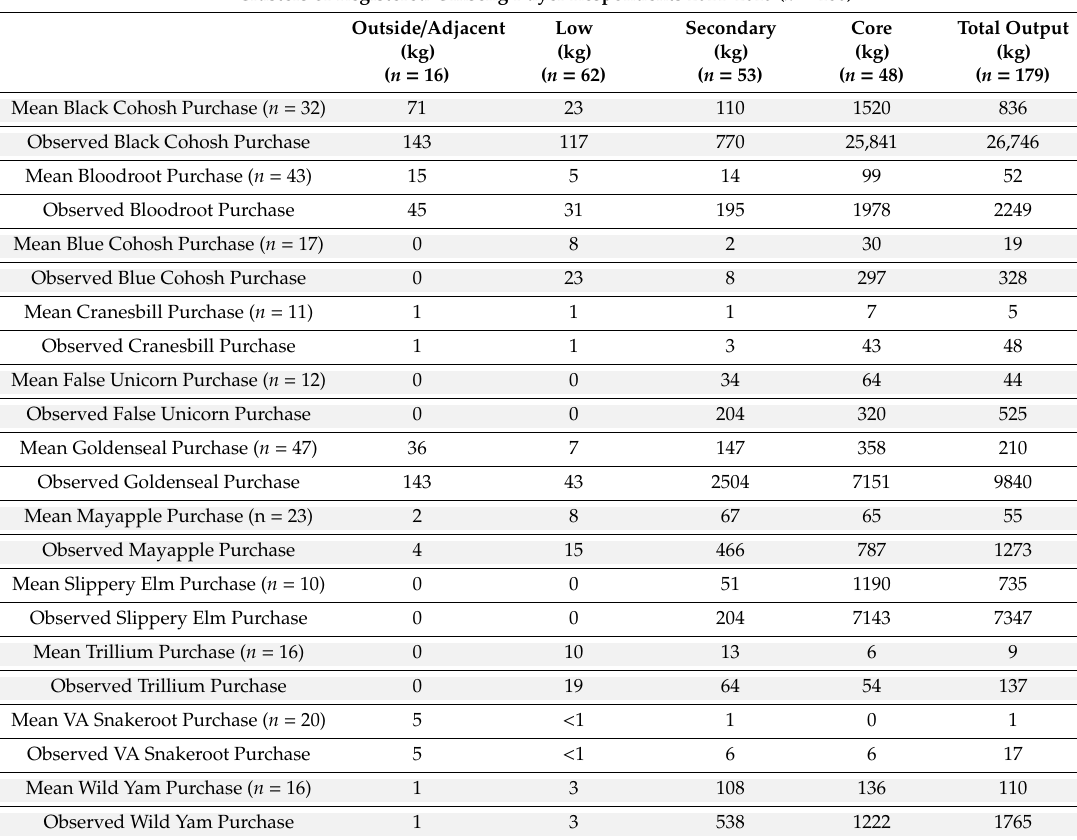
Table 7. Mean and total purchased volume of 11 o ff -root NTFP species reported by respondents in a combined data set from surveys of registered ginseng buyers in 2014 and 2015. Respondents are categorized in clusters determined using predictors of buying behavior based on